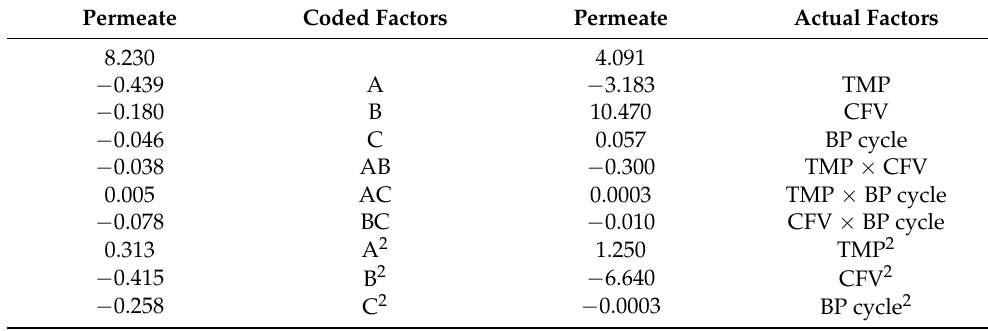
Table 10. Permeate volume-regression polynomial coefficients in terms of coded factors and actual